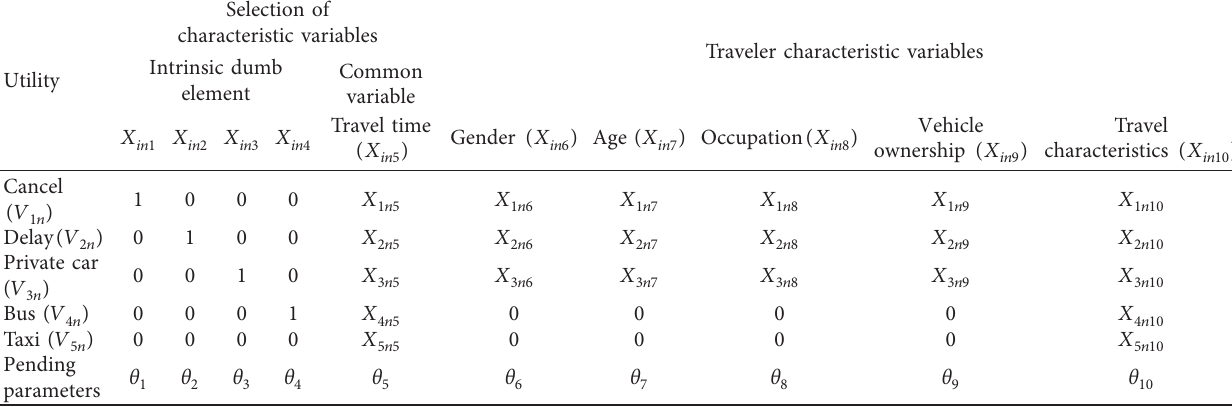
Table 3: Selection of model characteristic variables.